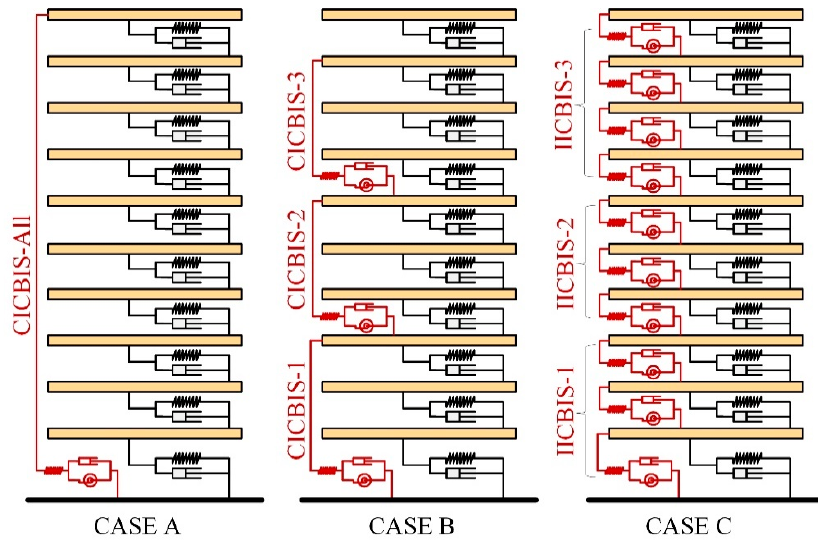
Figure 9. Schematic of the benchmark building with the cable-bracing inerter systems (CICBISs) and inter-layer-installed CBISs (IICBISs).